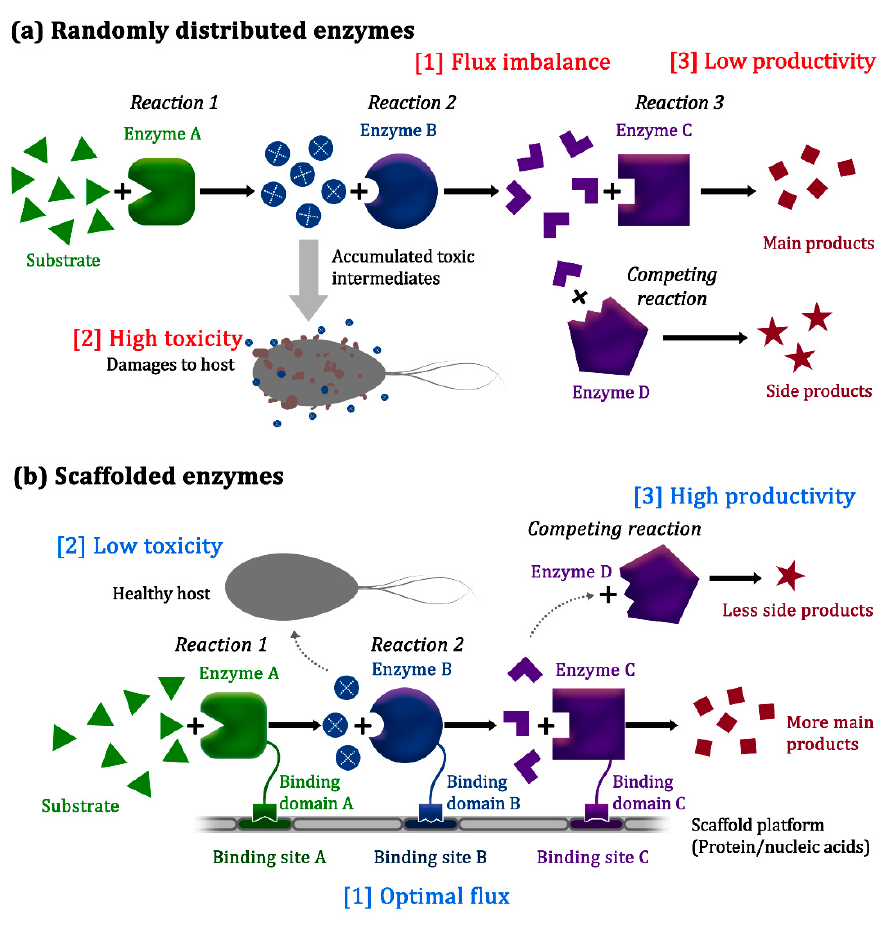
Figure 1. Spatial organization of pathway enzymes for efficient biosynthetic reactions. ( a ) Without spatial organization, pathway enzymes are randomly distributed, and their substrates also diffuse freely in the cell, which might result in (1) flux imbalance due to varying enzyme kinetics, (2) reduced cell viability due to the accumulation of toxic intermediates, and (3) low productivity due to diversion of the metabolic flux through competing pathways. ( b ) Synthetic scaffold systems organize the pathway enzymes and facilitate the substrate channeling effect for increasing pathway efficiency, thereby limiting the accumulation of toxic intermediates and reducing flux diversion to competing pathways [10].